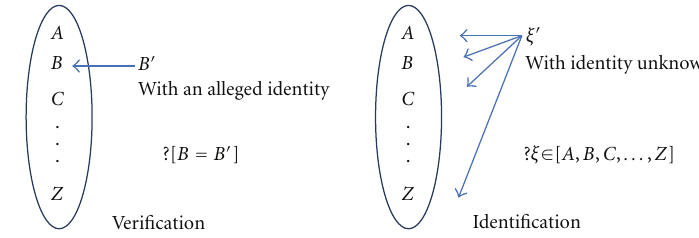
Figure 1: Workings of voice verification and voice identification systems.